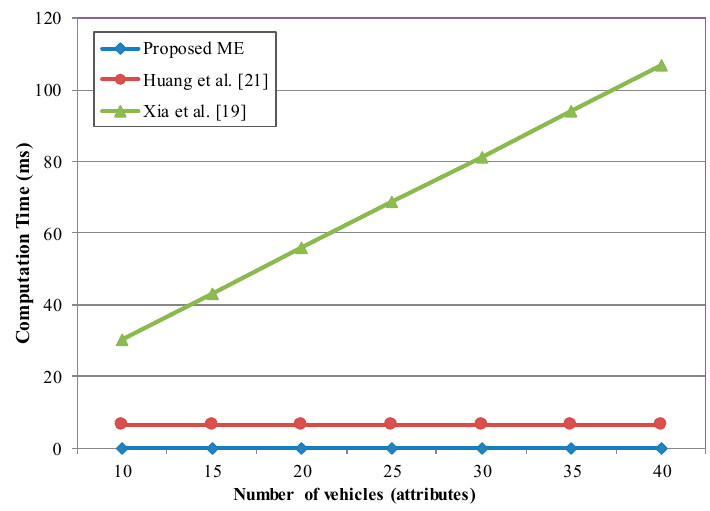
Figure 14. Computation cost of message encryption.